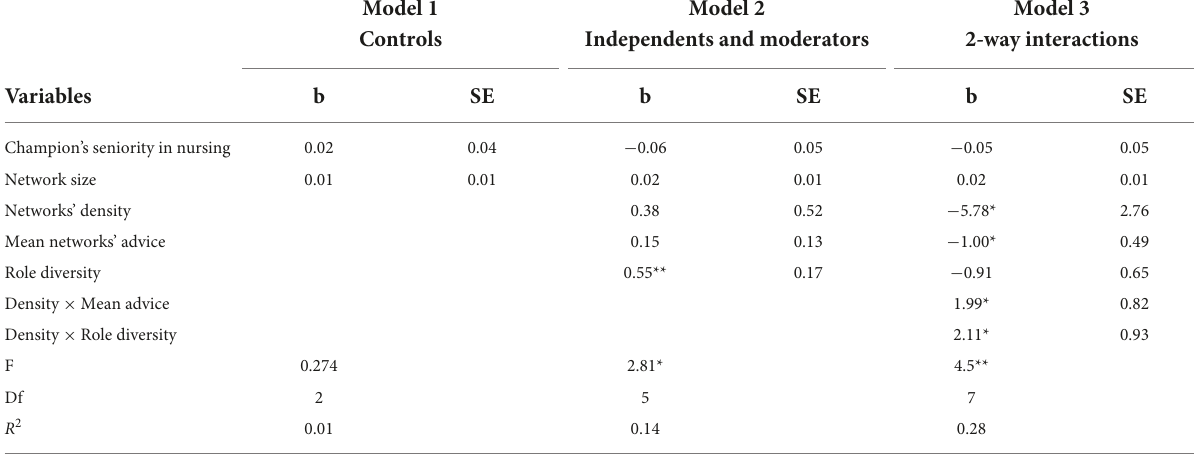
TABLE 3 Results of the linear regression analysis for predicting projects’